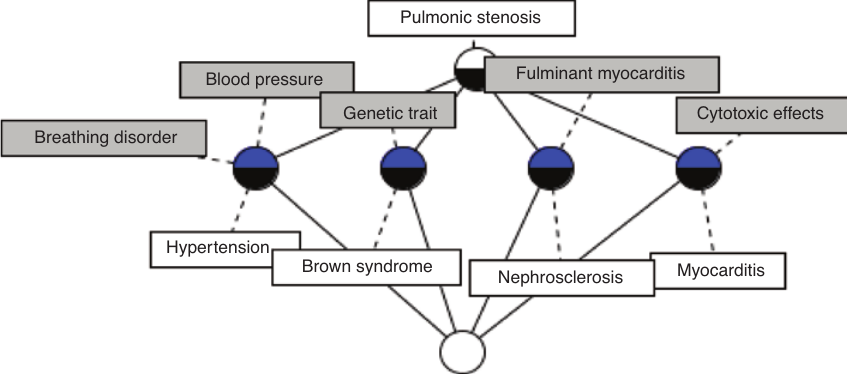
Figure 6: Part of a Concept Lattice Generated from the Original Dataset Using Our Proposed